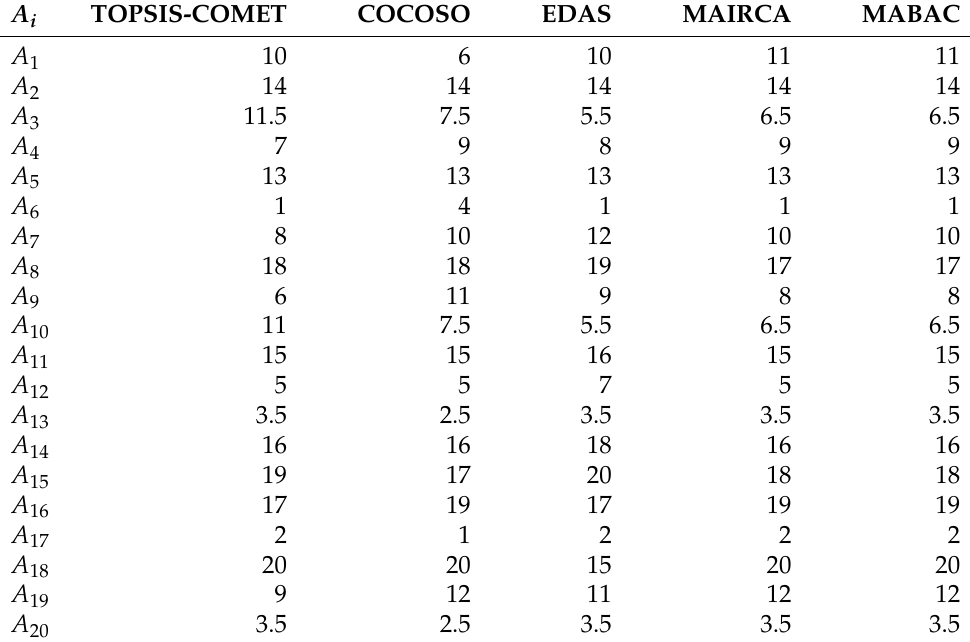
Table 6. Final rankings obtained with MCDM methods for a small set of